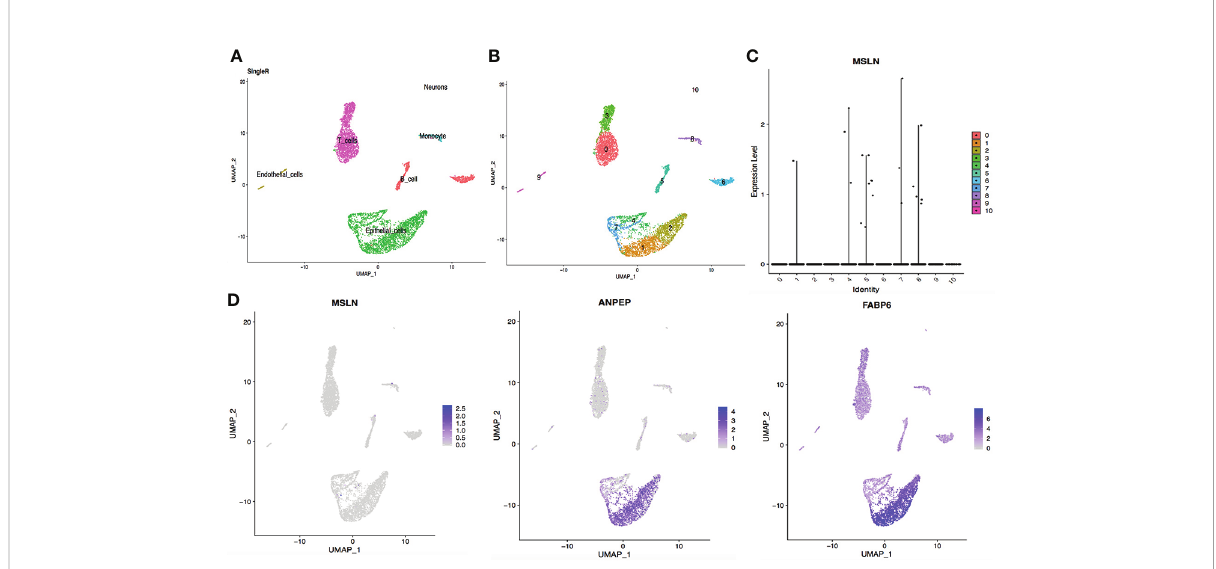
FIGURE 5 Analysis of scRNA-seq data from ileal cells showing low MSLN expression. (A) Cell types in the ileum according to SingleR. (B) Cells in the ileum were categorized into 11 different clusters, numbered 0 to 10. (C) Violin plot of MSLN expression distribution in these 11 different cell clusters. (D) Scatter plots showing the cluster of cells with MSLN expression also expressed the typical ileal cells markers ANPEP and FABP6.